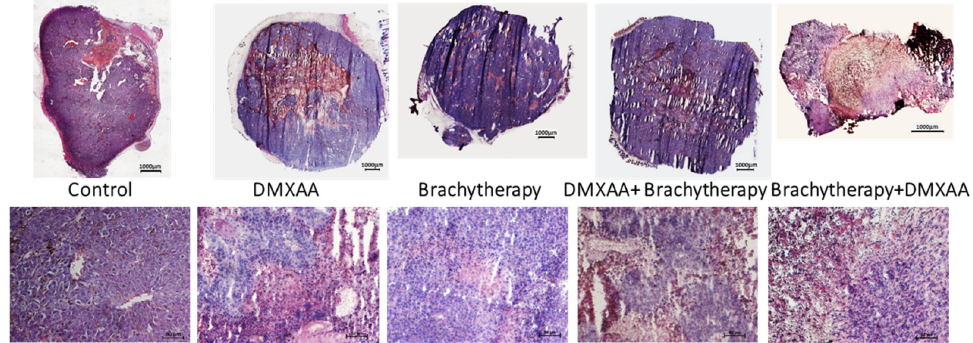
Figure 2. Hematoxylin eosin staining of B16-F10 tumor tissue. Twenty days after tumor inoculation tumors were removed and stained with hematoxylin and eosin. Tumor sections were imaged using light microscope. The scale bar is 1000 µ m in the upper pictures and 50 µ m in the lower